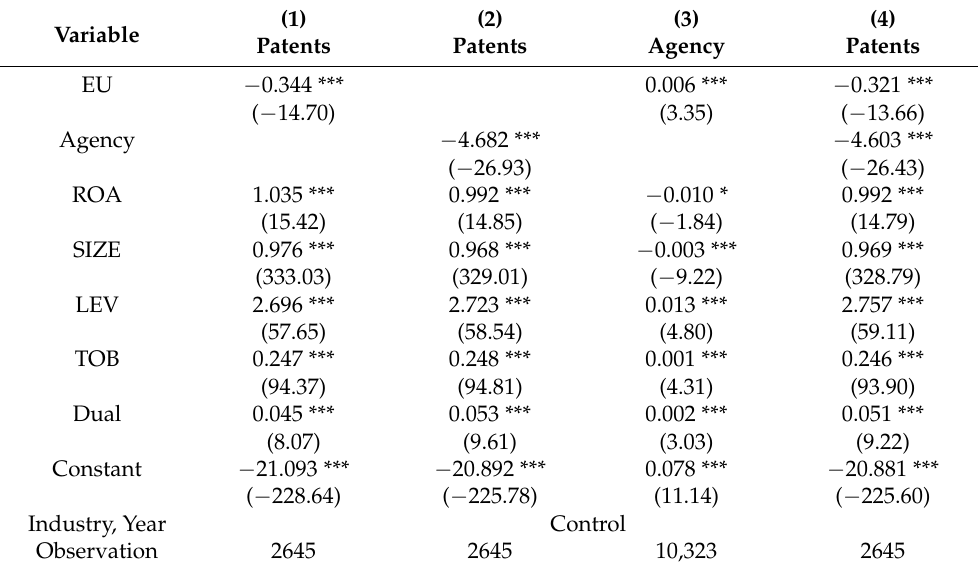
Table 6. Regression analysis of environmental uncertainty, the second type of agency problem and innovation output